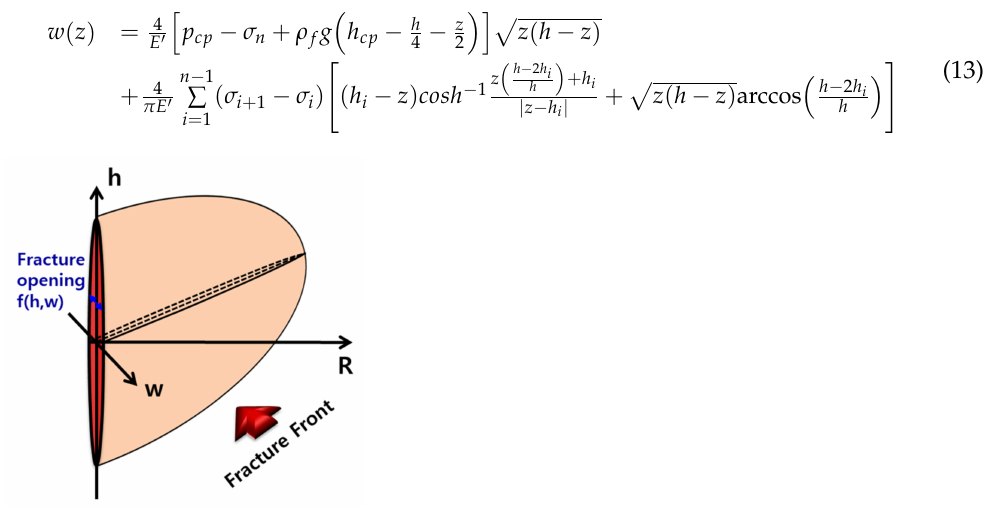
Figure 5. The predicted 3D shape of the